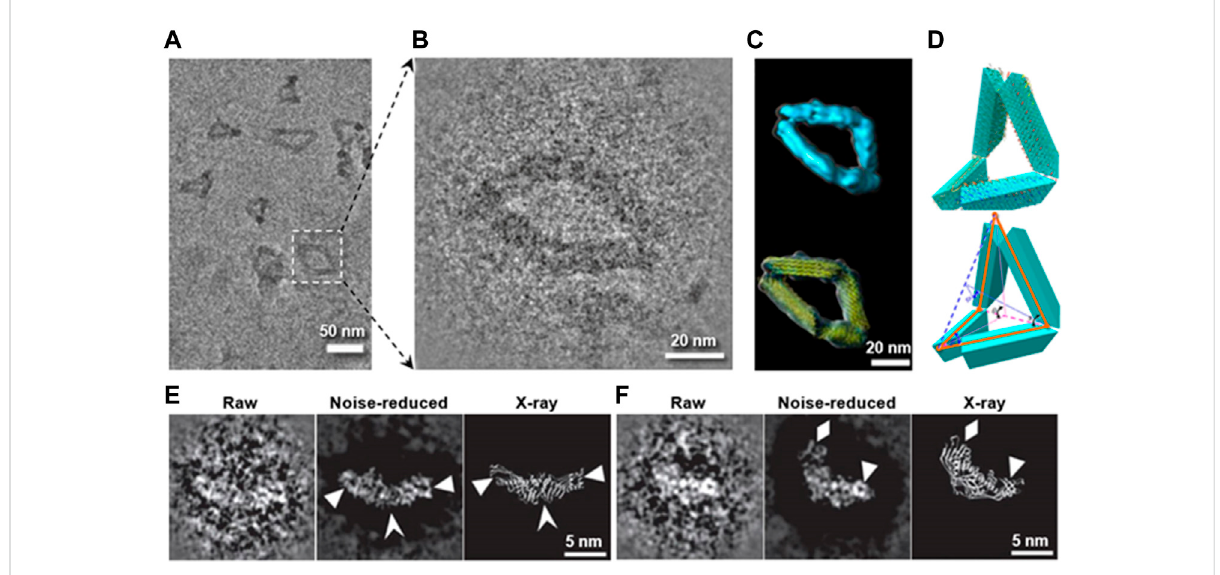
FIGURE 5 Preventing the radiation damage and raising the image contrast by heavy metal ion. (A) Overview cryo-positive-staining (cryo-PS) EM image of DNA origami in vitreous ice. (B) Magni fi ed image of DNA origami boxed in (A) . (C) Final 3D reconstruction (up) and its model with fl exible fi tted structure (yellow ribbon). (D) Schematic diagrams of the de fi ned internal angles within a particle. Reproduced with permission (Lei et al., 2018). (E) and (F) show two representative images of CETP imaged by cryo-PS (the left: a raw particle with reversed contrast, the middle: noise-reduced image of the raw particles, and the right: the X-ray crystal structure), in which the secondary structure details are indicated by arrowheads. Reproduced with permission (Zhang et al.,